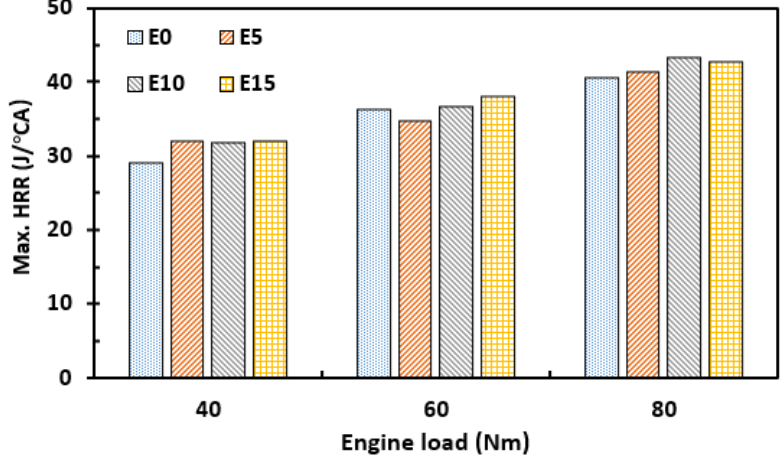
Figure 6. Maximum heat release rate.